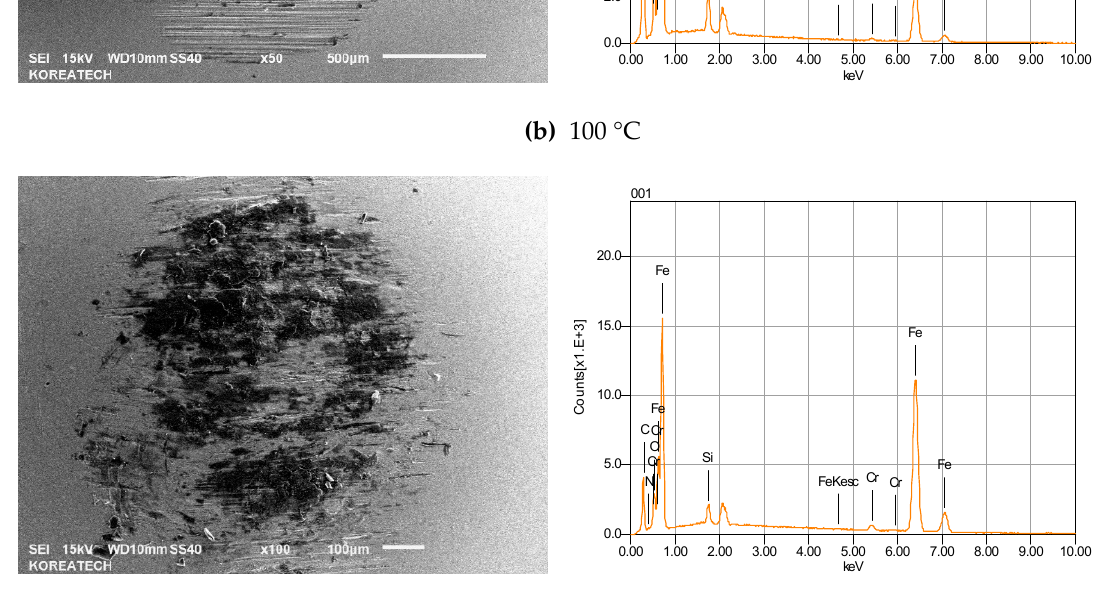
Figure 11. SEM images and EDS patterns of wear scars formed on the AISI52100 steel ball slid against the C/C-SiC composite at temperatures of 25, 100 and 200 °C.